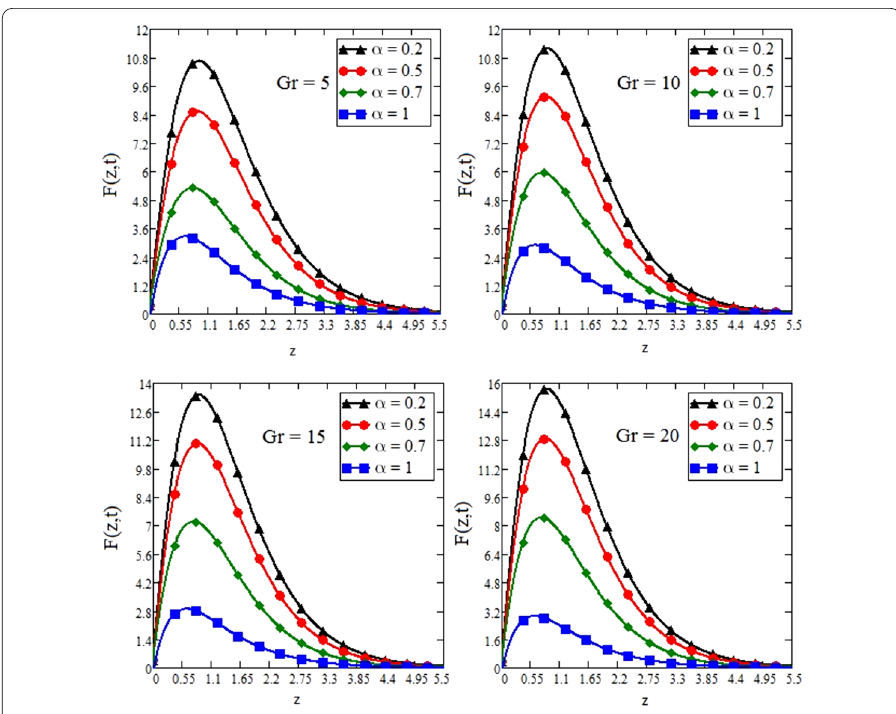
Figure 4 Impact of Gr on the velocity distribution of Jeffrey nanofluid